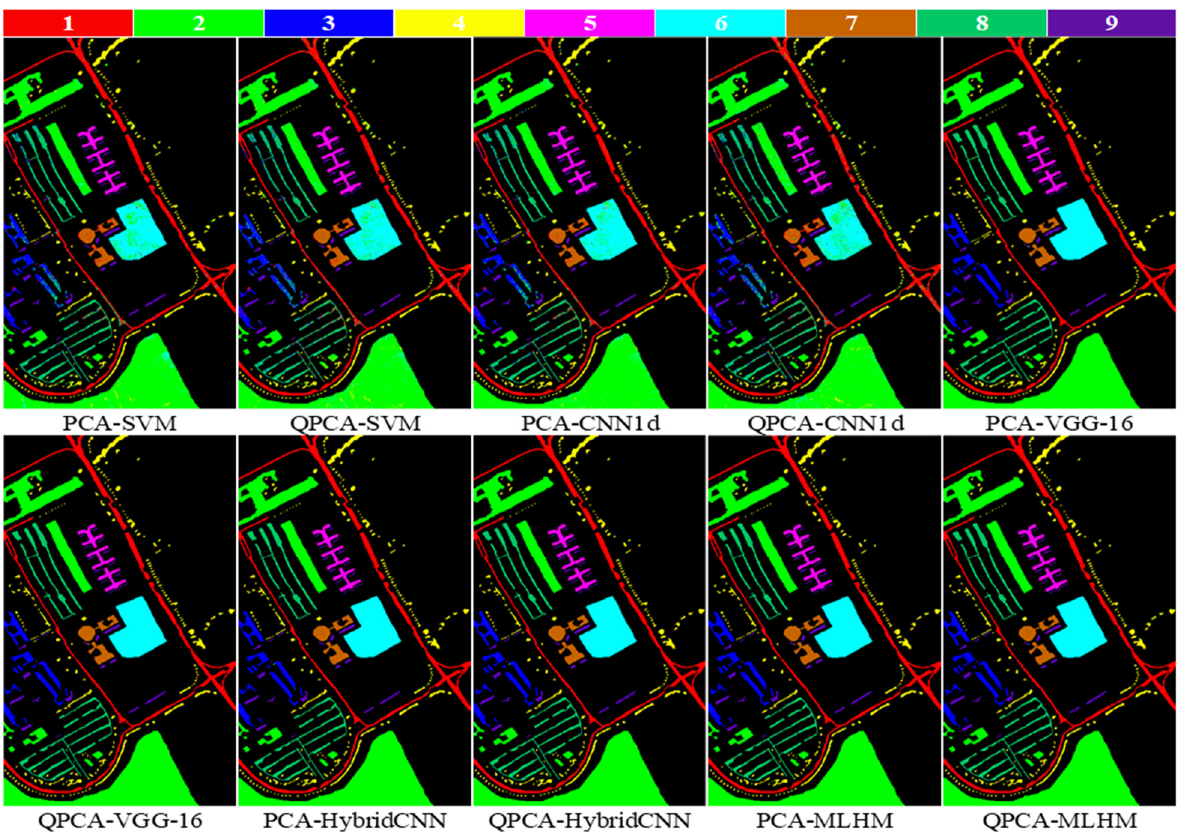
Figure 9. The output of the various models with PCA and QPCA preprocessing for the Pavia Uni- versity dataset.